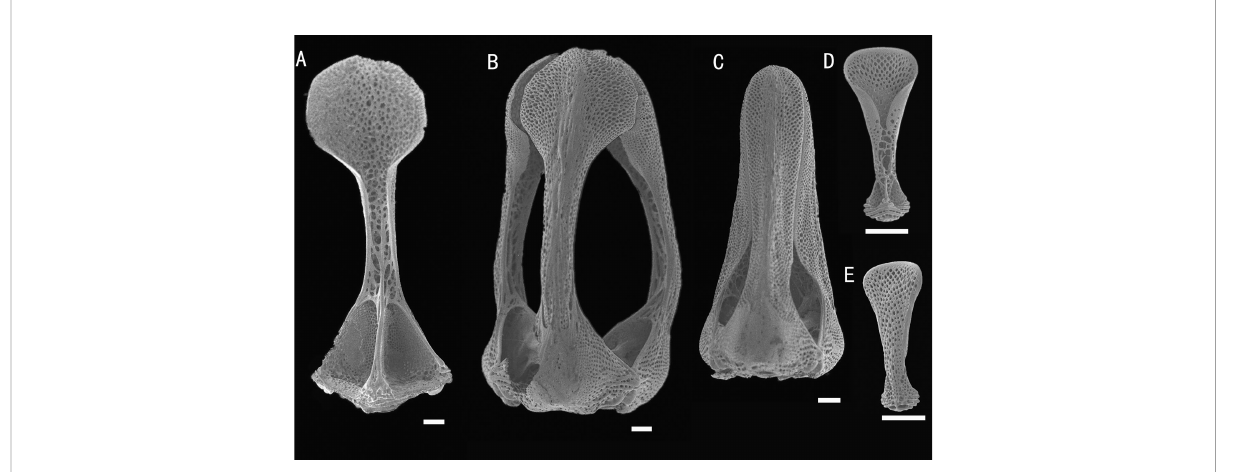
FIGURE 8 Araeosoma polyporum sp. nov.; holotype, MBM286949. SEM images of pedicellariae. (A, B) Involute tridentate pedicellaria: (A) individual valve (B) head. (C) Rostrate tridentate pedicellaria. (D, E) Valves of triphyllous pedicellariae. Scale bar , 100 m